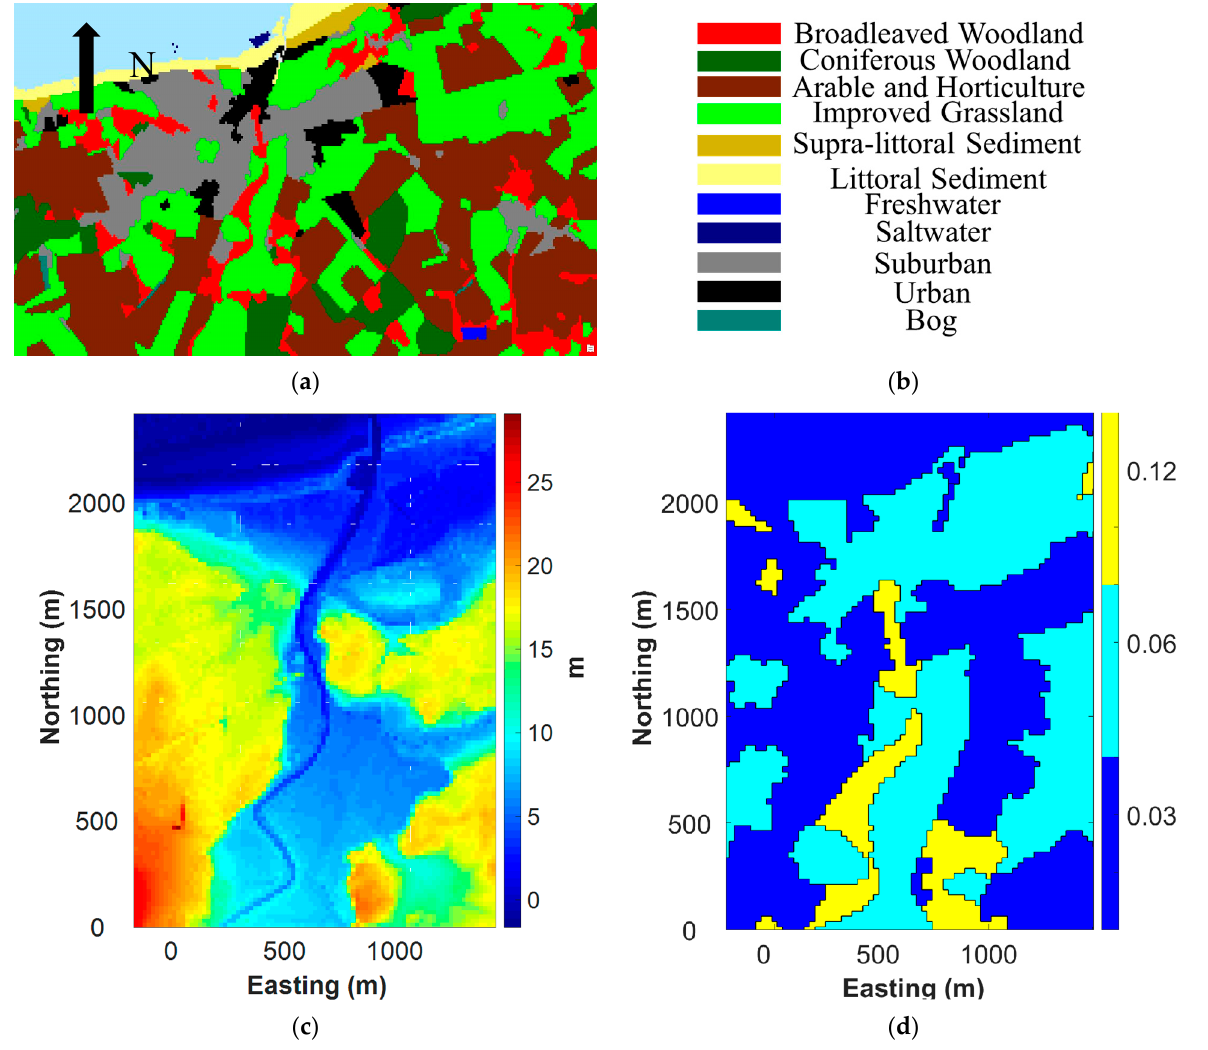
Figure 6. The flooding model setup: ( a ) Land Cover of the interested area [23] (© NERC (CEH) 2017. © Crown Copyright 2007. Ordnance Survey License); ( b ) the legend of the land cover; ( c ) the DTM data with 2 m resolution (source: Scottish Government data archive © Open Government License); ( d ) the final, tuned roughness of the flood plain based on the land cover at the ( a ), with a de-refined 20 m resolution. The north and south boundary of the domain is seaside and river side, respectively, where the boundary conditions vary in various scenarios. The coordinate system is offset from the original dataset but keeping the scale and distance for confidentiality issues.